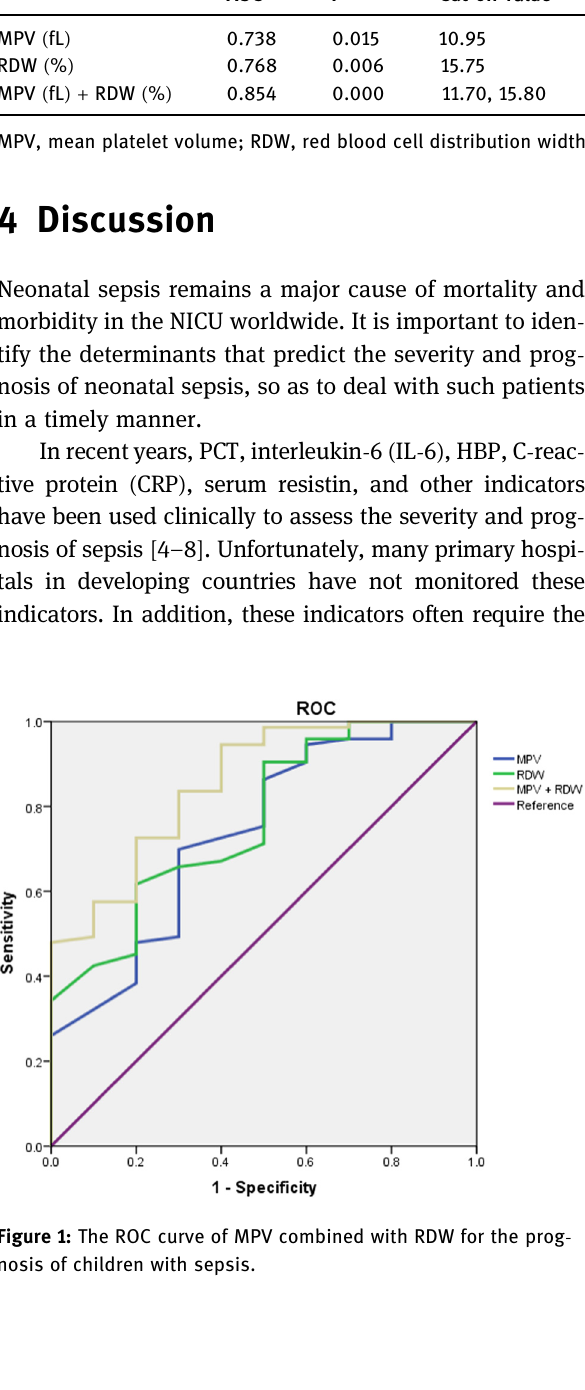
Table 5: The AUC of MPV combined with RDW